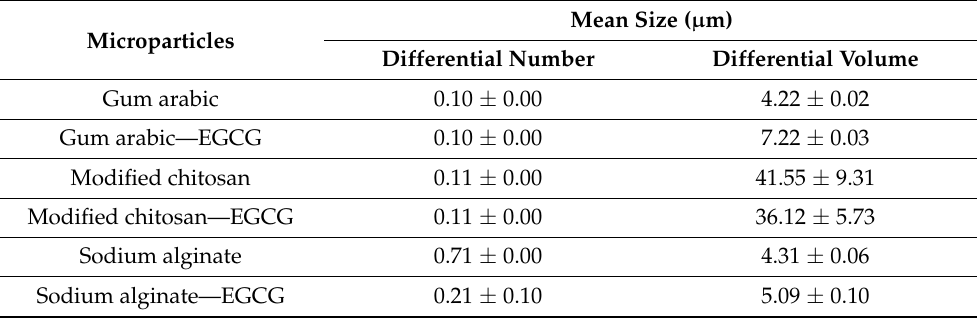
Table 1. Microparticles’ (empty and containing EGCG) mean size results obtained, considering a differential volume and number distribution, prepared with different encapsulating